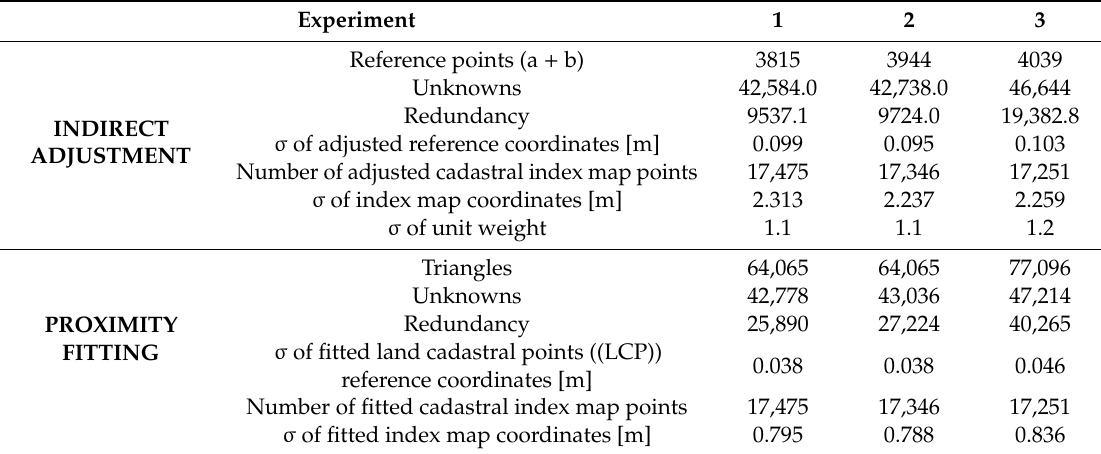
Table 3. Results of indirect adjustments and proximity fittings in the three